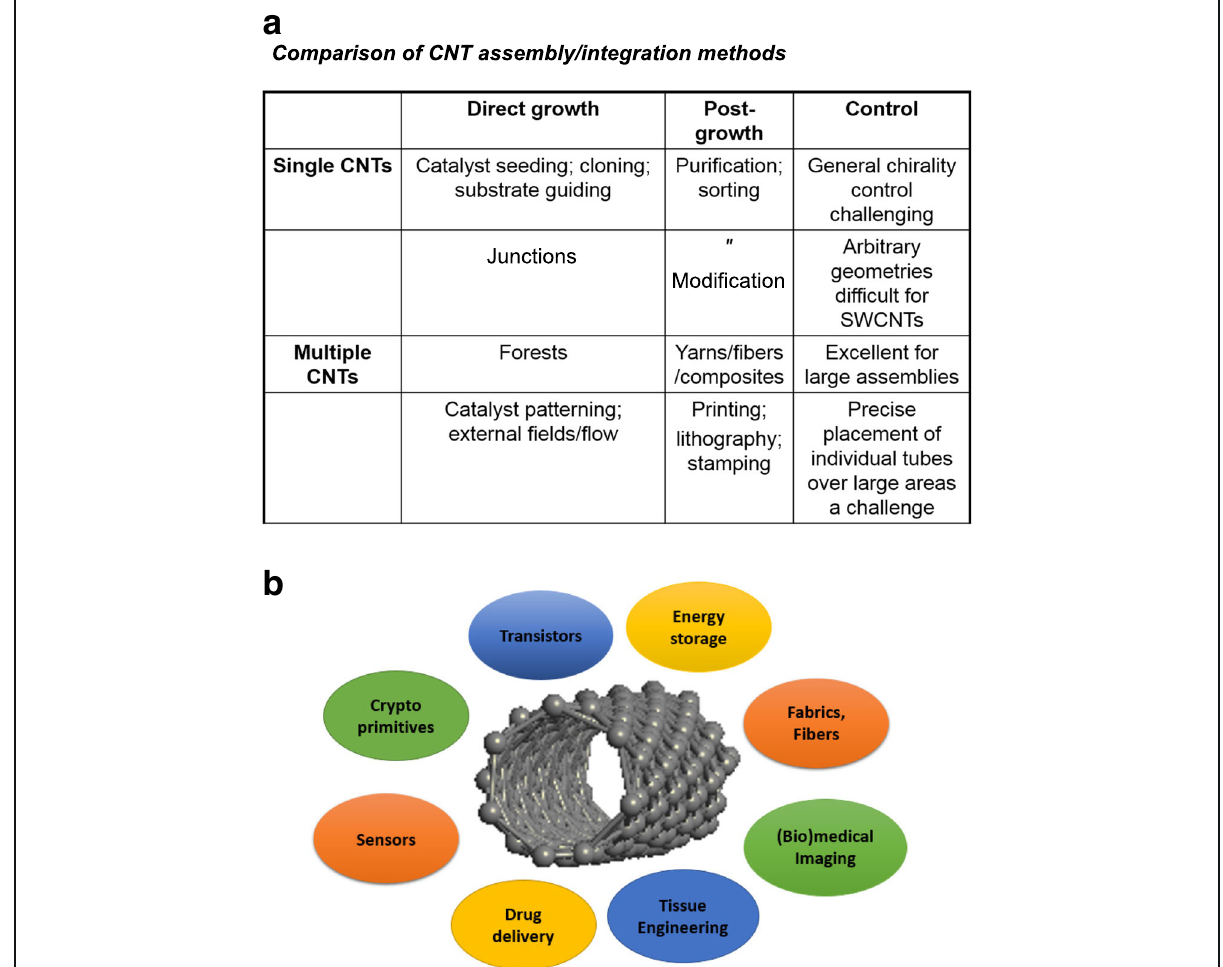
Fig. 44 a Summary description of CNT assembly and integration techniques. b Overview of various emerging applications of